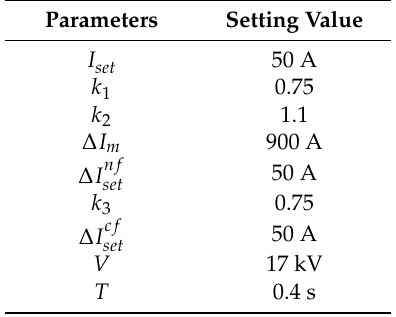
Table 3. Parameters of the fault identification method.